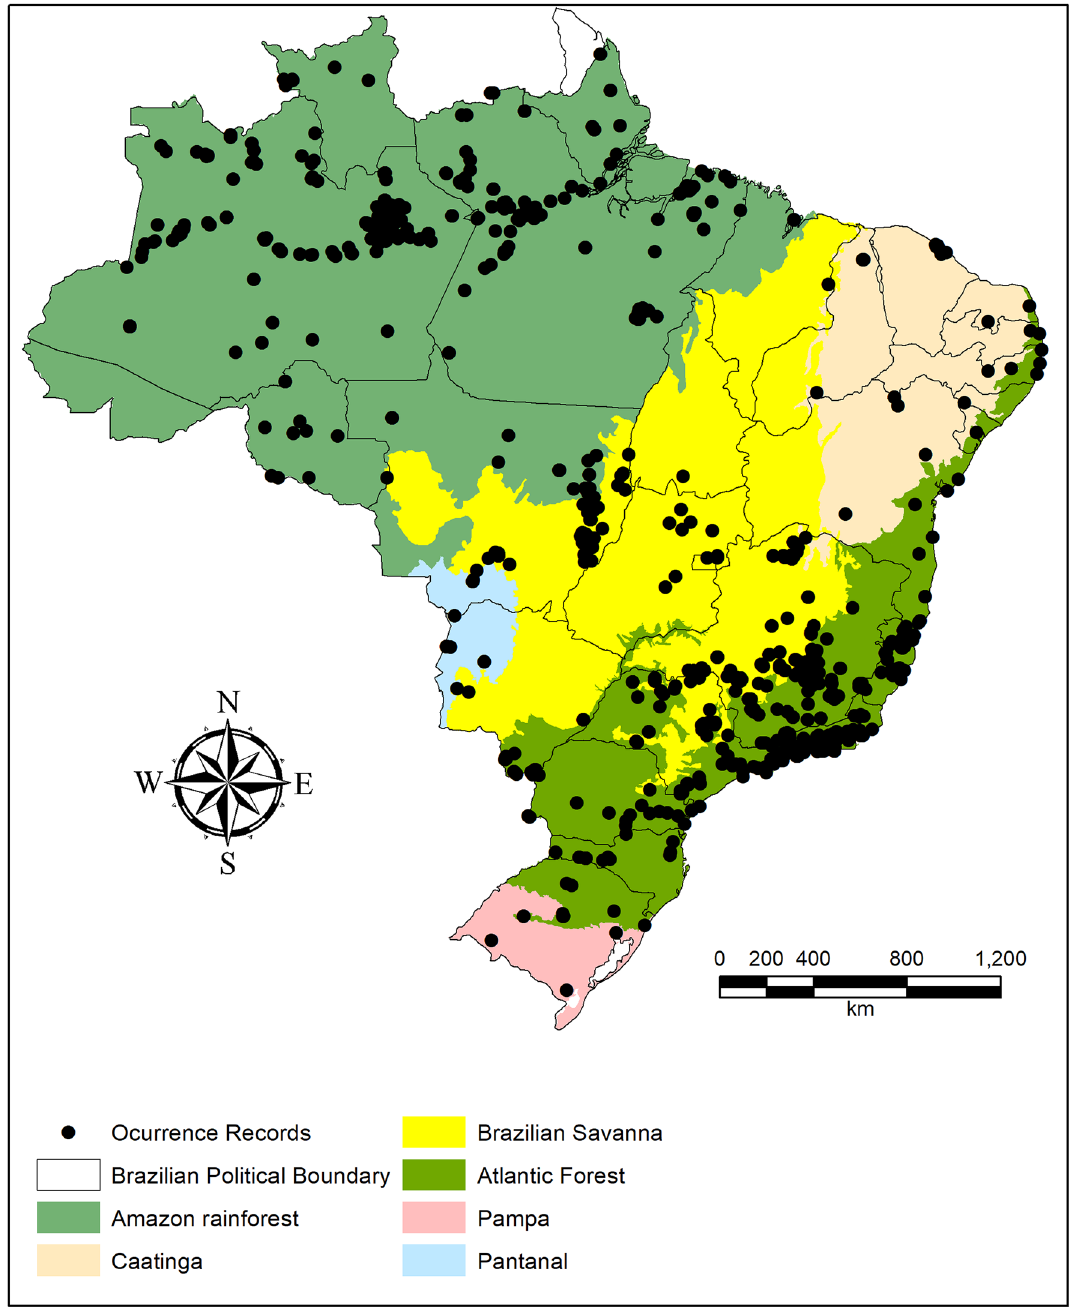
Figure 1. Gerromorpha species occurrences used in the species distribution models (SDM). The figure was built on the R environment 63 portion in the northern Atlantic Forest (Fig. 2a). The Atlantic Forest and the Amazon had higher richness than predicted based on random sampling of grid cells (Table 2). When evaluating total beta diversity, the highest values were found for the Northern Region of Brazil (Fig. 2b), and the Amazon biome had higher beta diversity than predicted (Table 2). However, when evaluating the components of beta diversity, the turnover portion (Fig. 2d) was greatest in the Southern Region of Brazil (Fig. 2d). On the other hand, in the nested portion we found the areas with the lowest species richness values (the northern Cerrado and Caatinga, as well as the central Amazon); these are the areas with the highest nestedness values for the Gerromorpha (Fig. 2c). The map of cell importance for conservation (Fig. 3) shows that cells in the northern Amazon, the eastern and western Cerrado and in the coastal portion of the Atlantic Forest are important for Gerromorpha conserva- tion, and many locations that are considered priority areas are outside of the conservation units. In general, the biomes did not differ in terms of importance for the conservation of Gerromorpha (Table 3), and we observed for